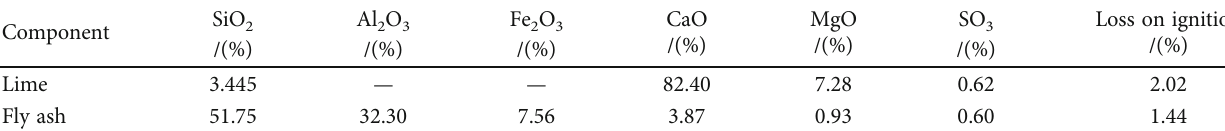
Table 1: Main chemical components of lime and fl y ash.